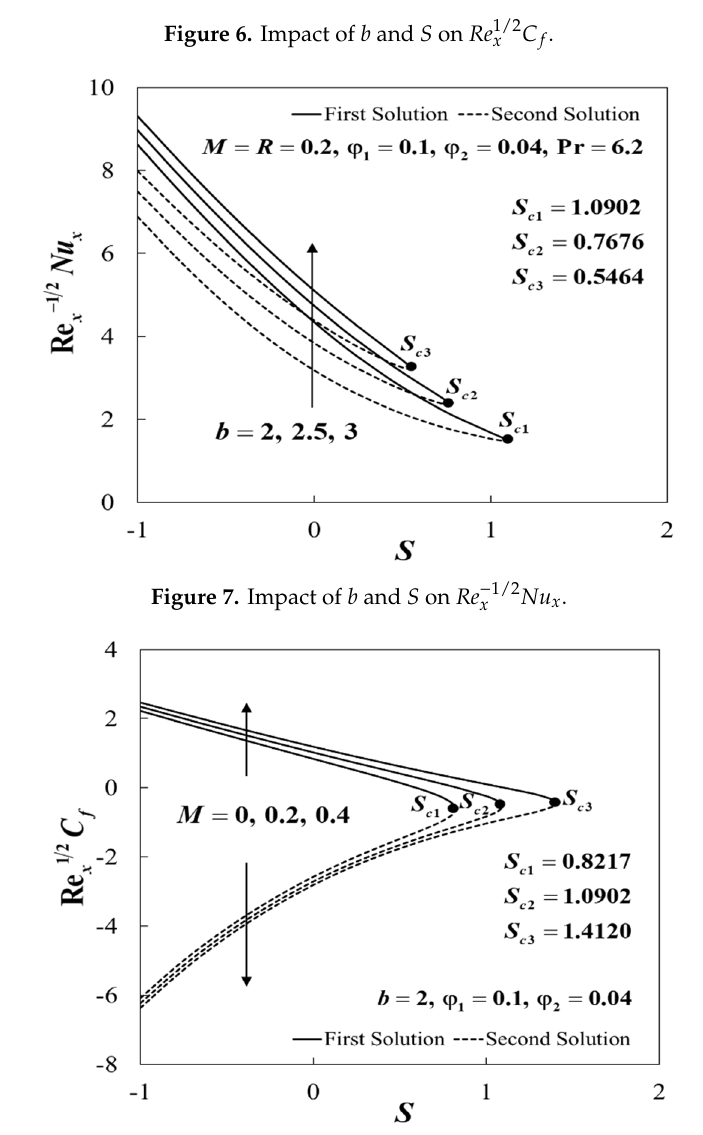
Figure 9. Impact of 𝑀 and 𝑆 on 𝑅𝑒 (cid:3051)(cid:2879)(cid:2869)/(cid:2870) 𝑁 𝑢 (cid:3051) .